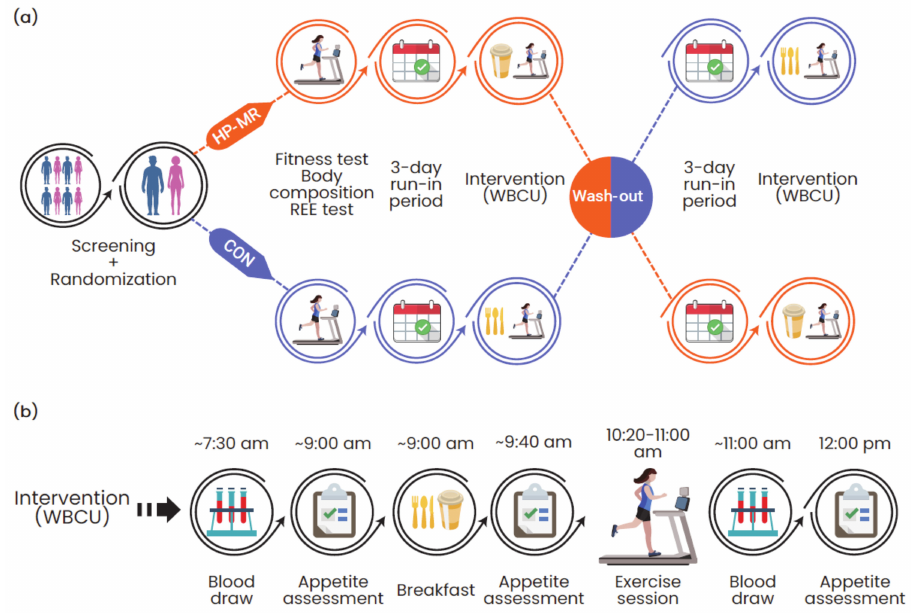
Figure 1. ( a ) Overview of the experimental protocol and ( b ) activities performed during each condition. Abbreviations: CON: control; HP-MR: high-protein meal replacement; REE: resting energy expenditure; WBCU: whole-body calorimetry